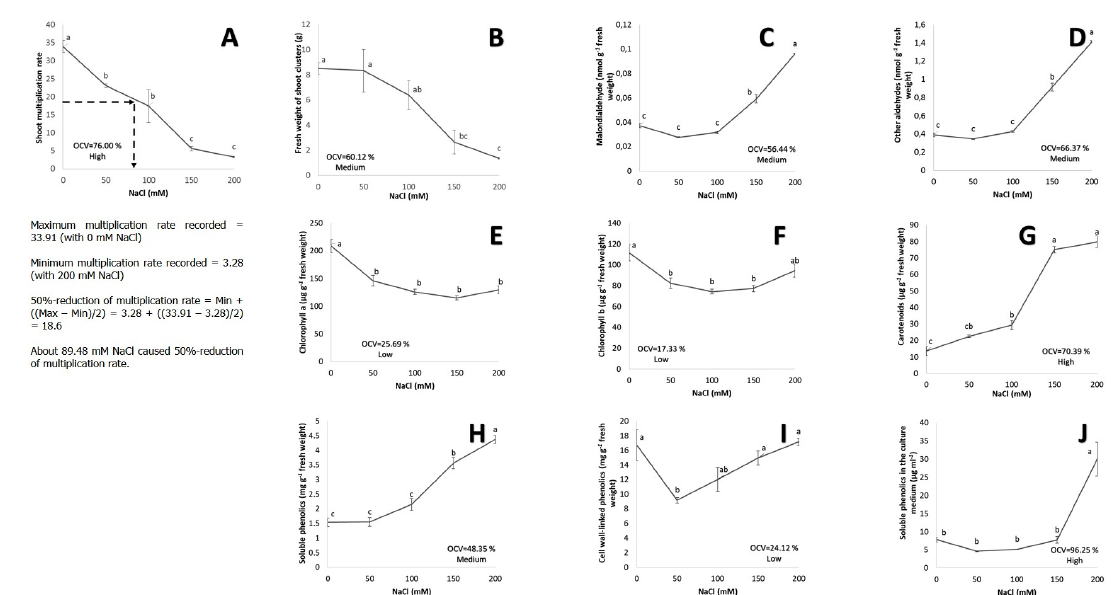
Fig. 2: The effect of sodium chlorine on sugarcane during microprogagation in temporary immersion bioreactors. Shoot dusters were formed around each explant. Vertical bars represent SE. Results with the same letter are not statistically different (One-way ANOVA, Tukey, p>0.05). Overall coefficient of variation (OCV) = (Standard deviation/Average) * 100. To calculate this coefficient, the five average values were considered. The higher the difference among results, the higher the overall coefficient of variation. Classification of OCVs: “Low” from 17.33 to 43.64%, “Medium” from 43.64 to 69.94% and “High” from 69,94 to